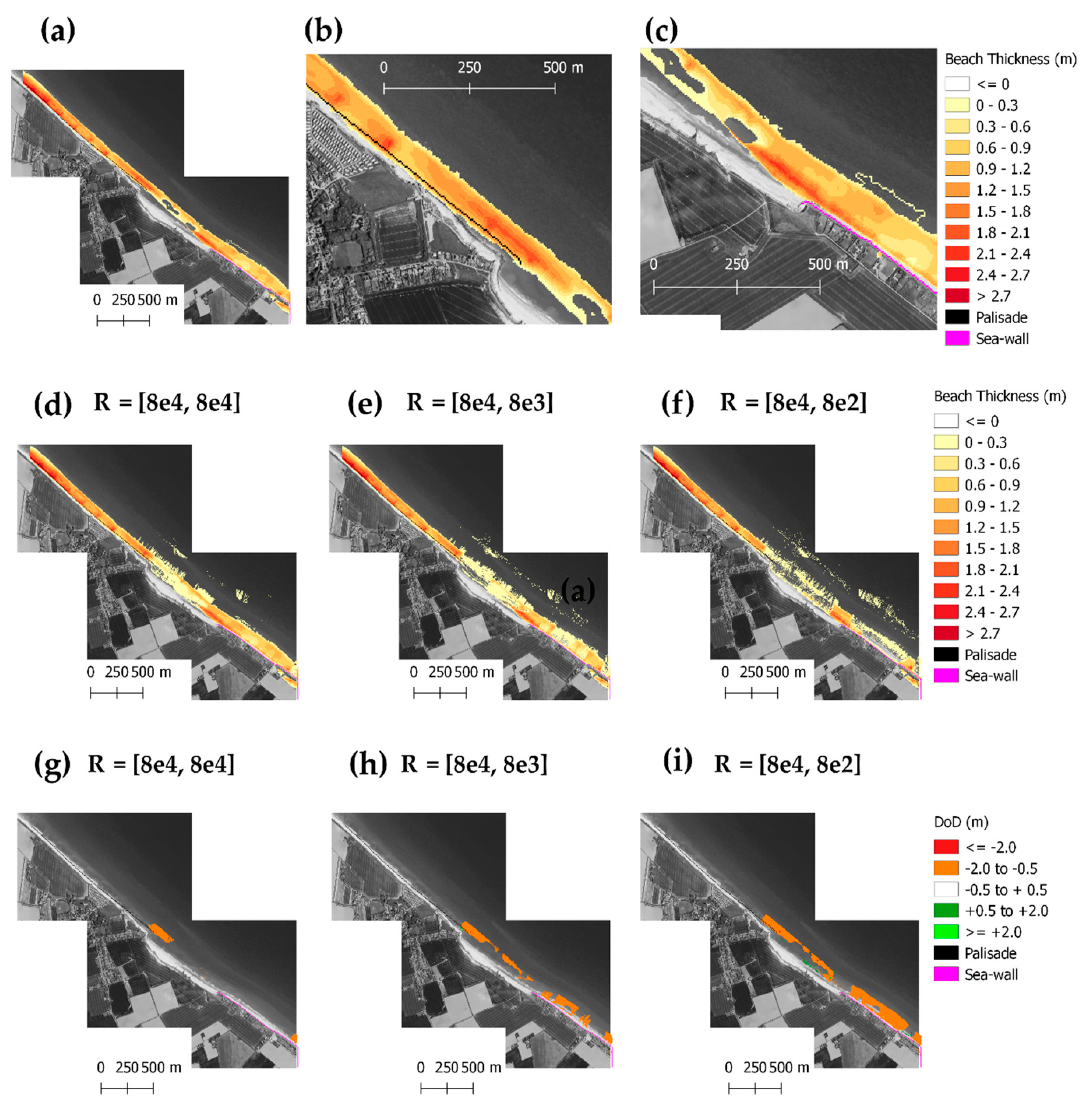
Figure 17. Initial and final simulated beach thickness; ( a ) initial beach thickness derived from the lithological model; ( b , c ) details of the palisade in the northern side of the embayment and seawall on the southern side of the embayment respectively; ( d – f ) shows final beach thickness for different R values (indicated as [R Platform , R Cliff ] (m 9/4 s 2/3 )); ( g – i ) shows the thickness difference between the final and initial beach thickness.